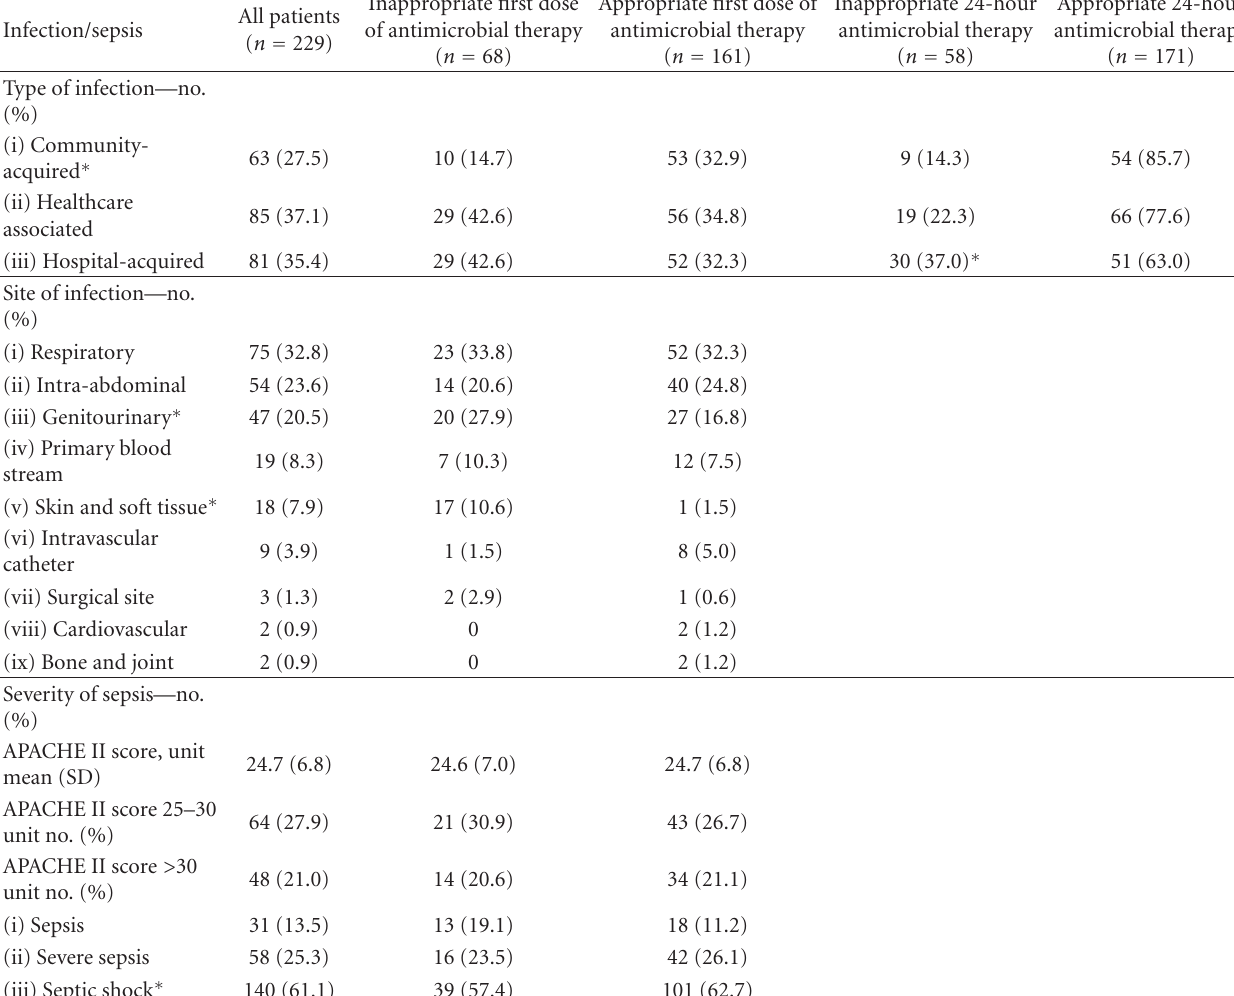
Table 2: Type and site of infection and severity of sepsis by appropriateness of empiric antimicrobial therapy. All Infection/sepsis